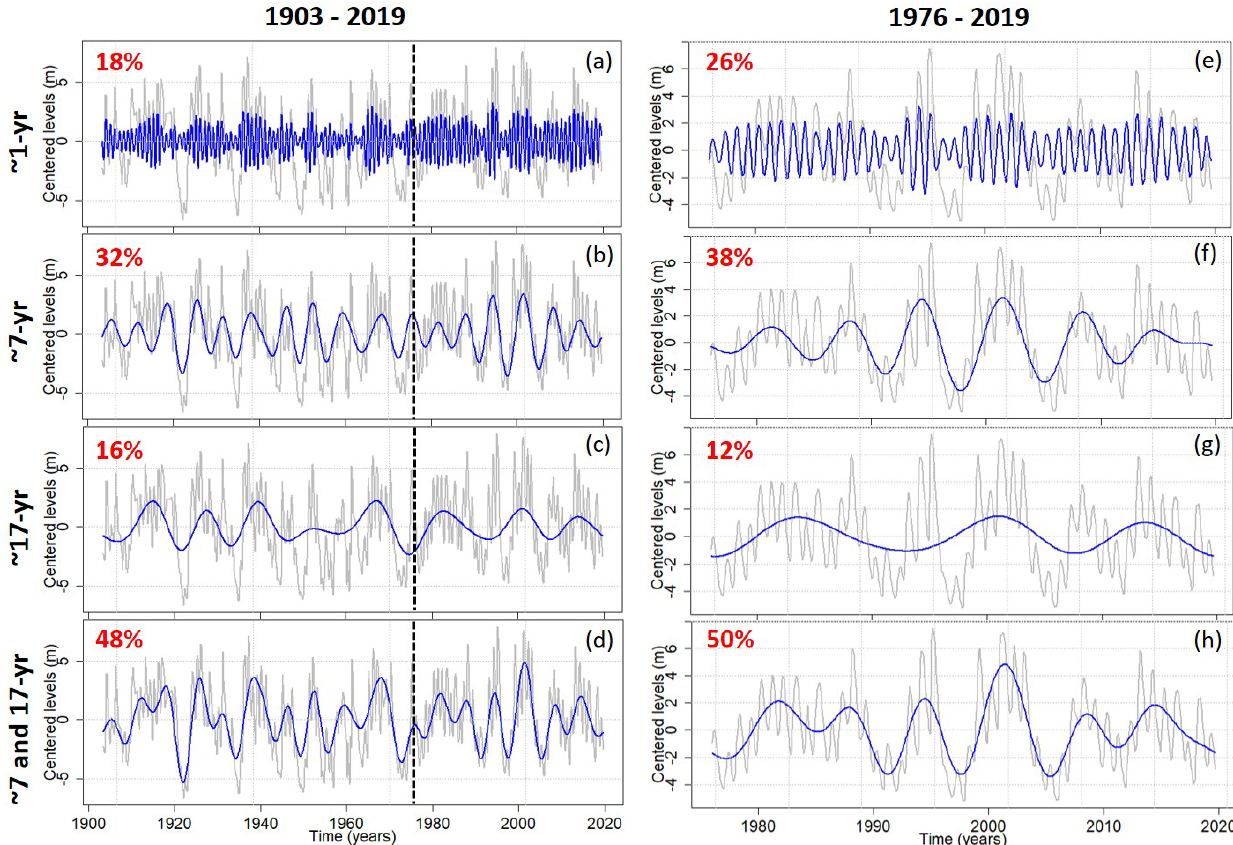
Figure 11. Maximum overlap discrete wavelet transform (MODWT) of groundwater levels at Tincques in the Seno-Turonian chalk of Artois– Picardy over the 1903–2019 and 1976–2019 periods. In gray the original time series is displayed, in blue the wavelet detail, and in red the energy